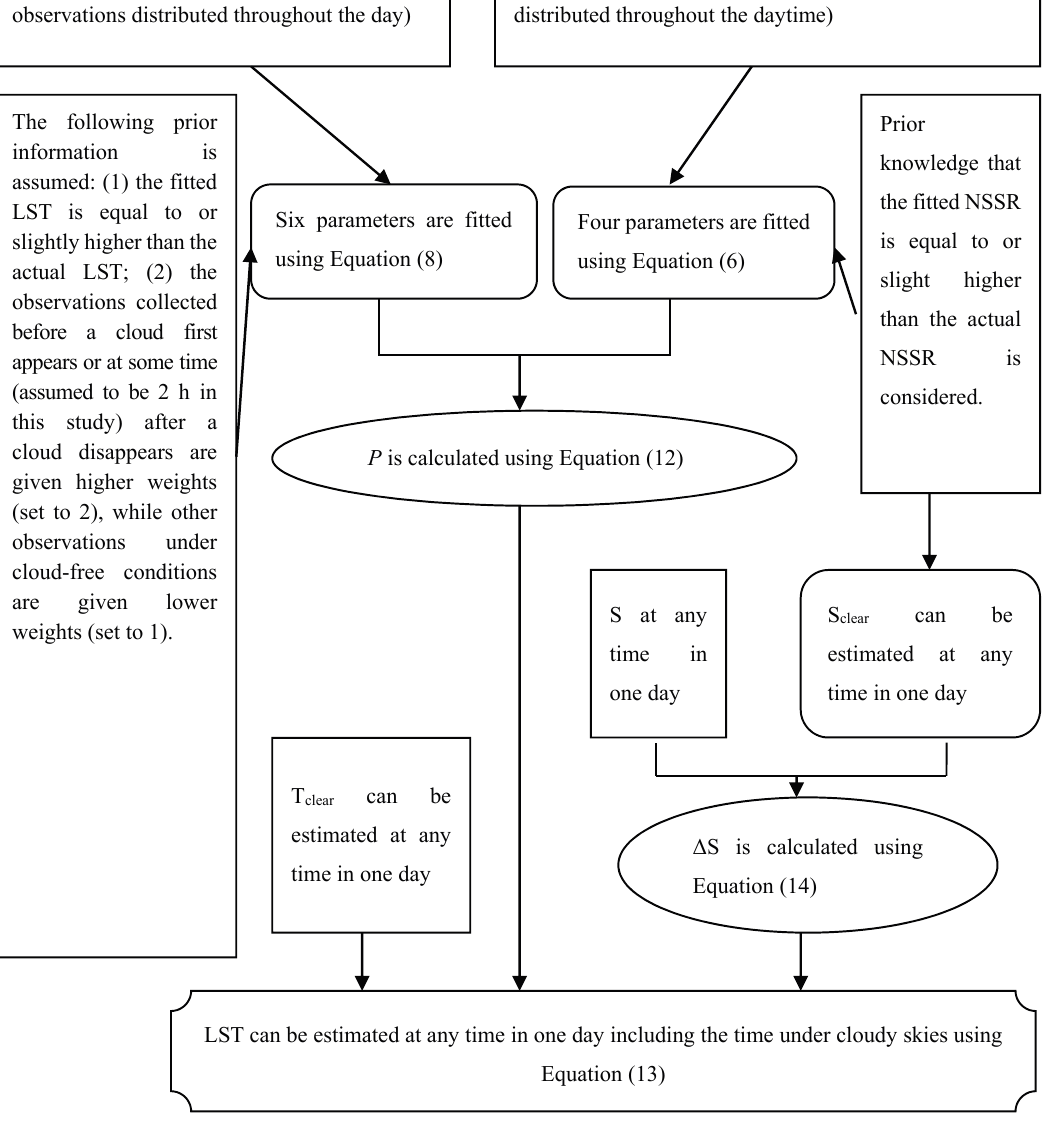
Figure 1. Flow chart of estimated LST under cloudy skies